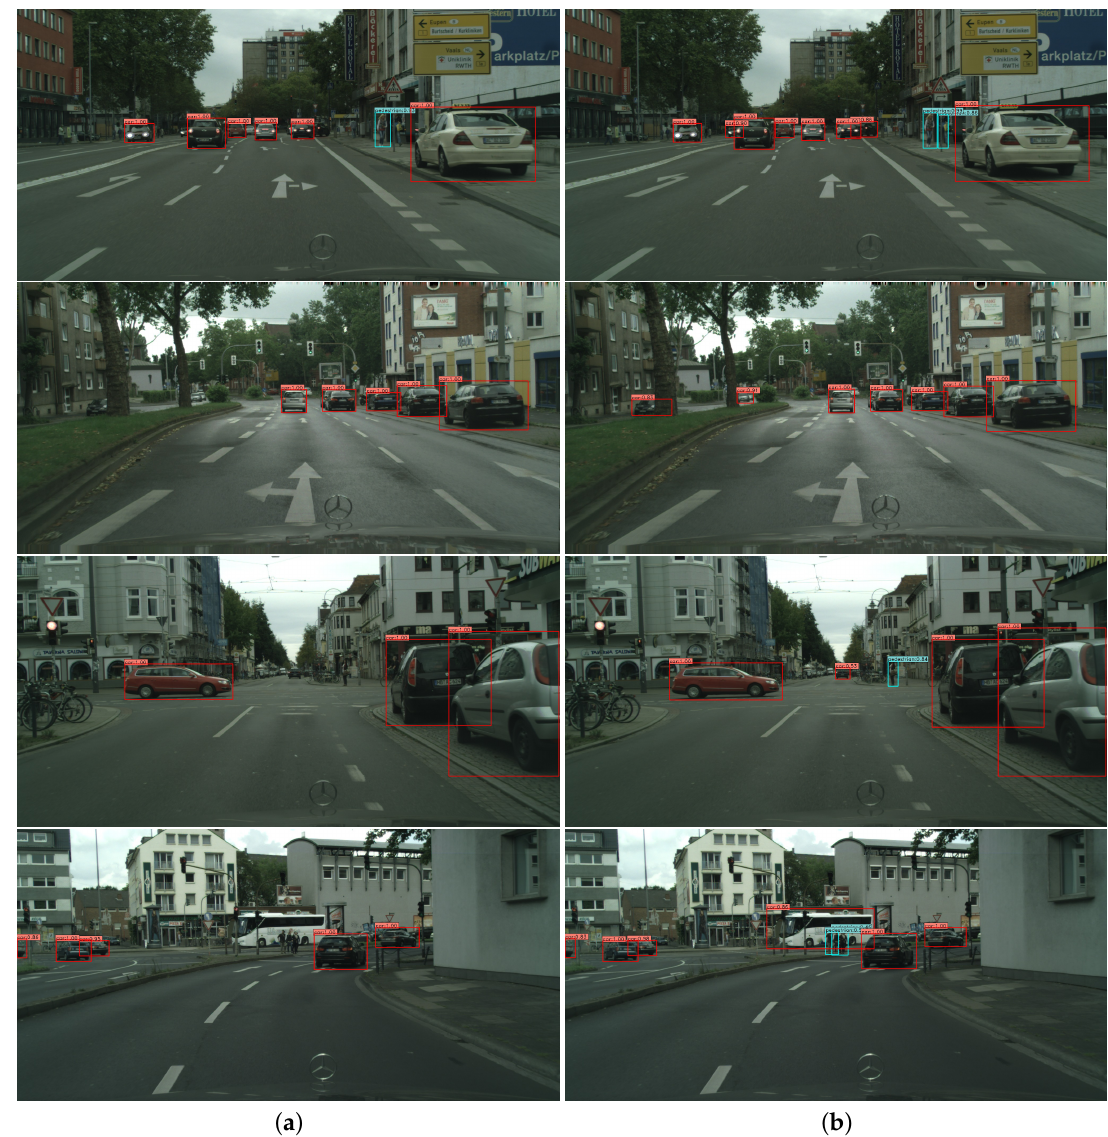
Figure 5. Detection examples on Cityscapes dataset with FPN and EFPN model. For each pair, one the left is the result of FPN ( a ) and on the right is the result of EFPN ( b ). We show detections with scores higher than